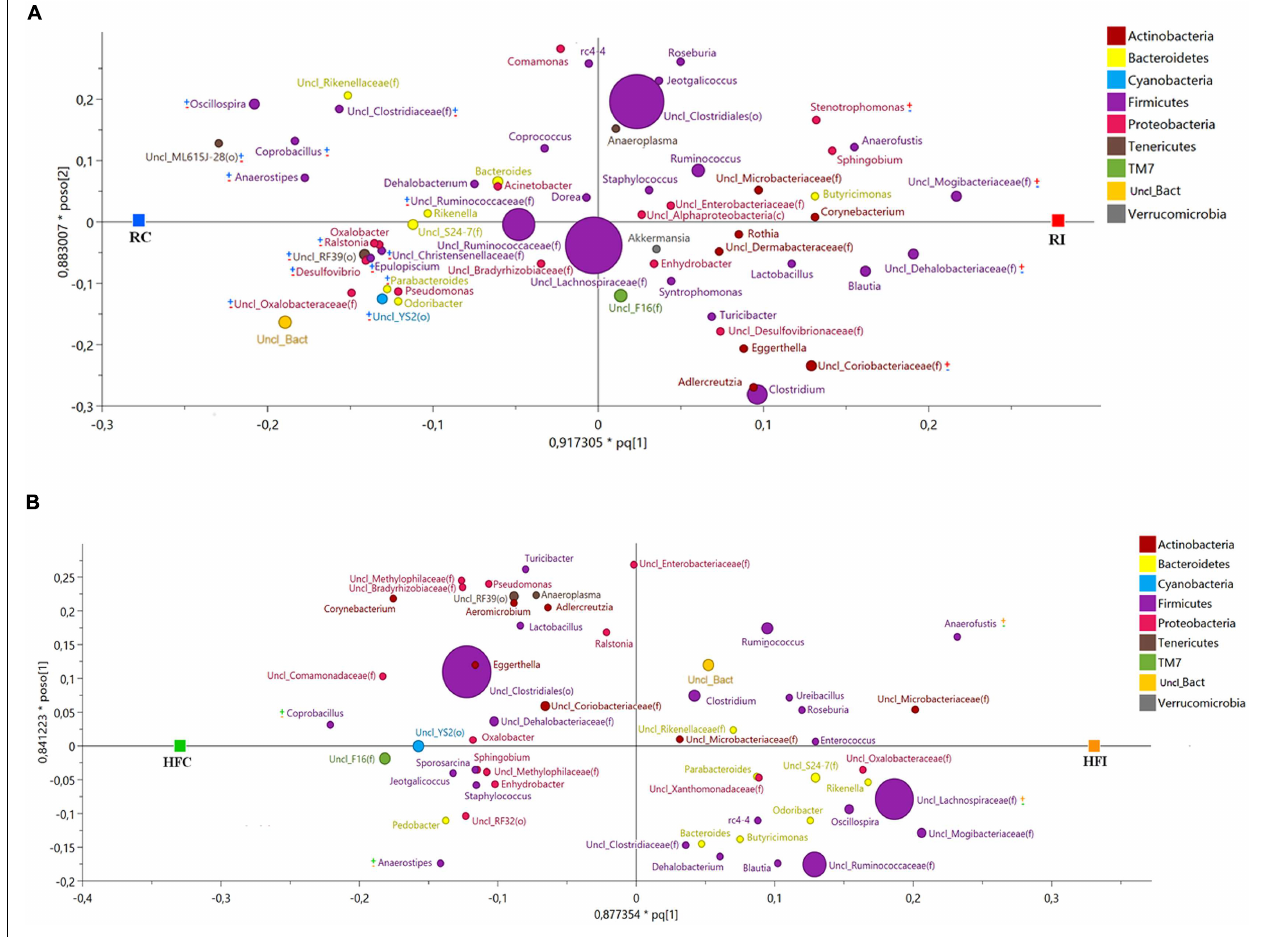
FIGURE 9 | Sacculus rotundus microbiota orthogonal projection to latent structures discriminant analysis (OPLS-DA) scatter Plot. The size of the spheres represents abundance. (A) OPLS-DA scatter plot for sacculus rotundus samples of animals fed with regular diet ( R 2 Y = 0.995; Q 2 = 0.765). The taxa with significant positive association with MAP infected animals are labeled with ( + ) and with negative association with MAP infected animal with ( − ). The taxa with significant positive association with control animals are labeled with ( + ) and with negative association with control animals with ( − ). (B) OPLS-DA scatter plot for sacculus rotundus samples of animals fed with high fiber diet ( R 2 Y = 0.921; Q 2 = 0.511). The taxa with significant positive association with MAP infected animals are labeled with ( + ) and with negative association with MAP infected animal with ( − ). The taxa with significant positive association with control animals are labeled with ( + ) and with negative association with control animals with ( −